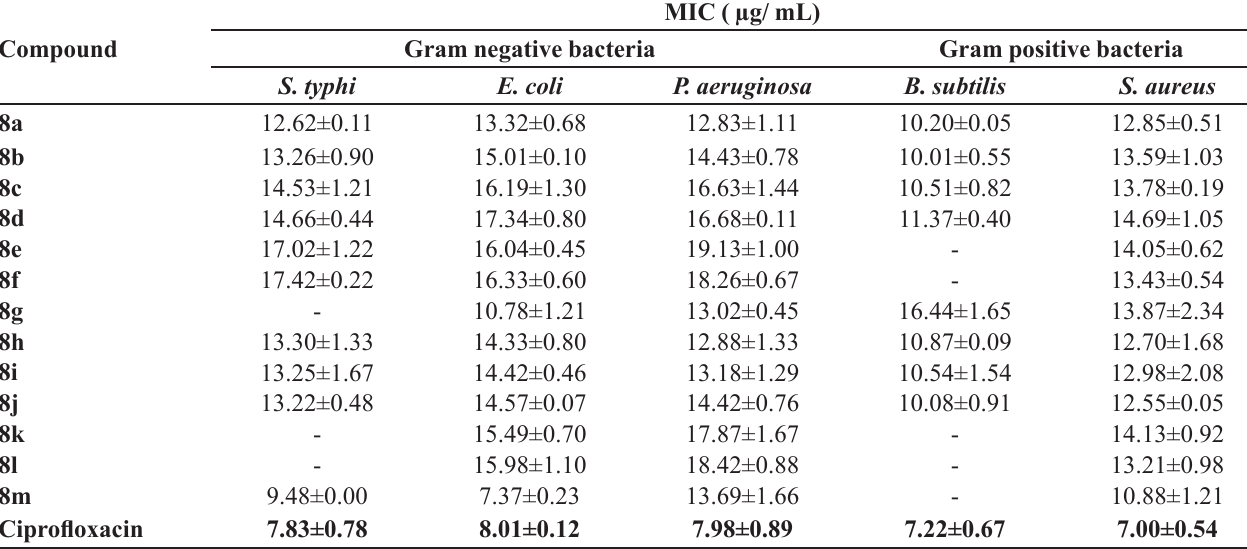
TABLE III - The MIC values of antimicrobial activity of the synthesized compounds